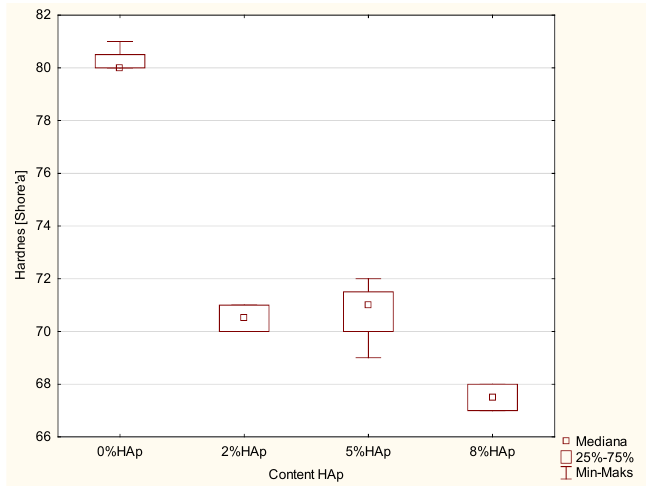
Figure 5. Statistically significant differences in hardness among examined groups.